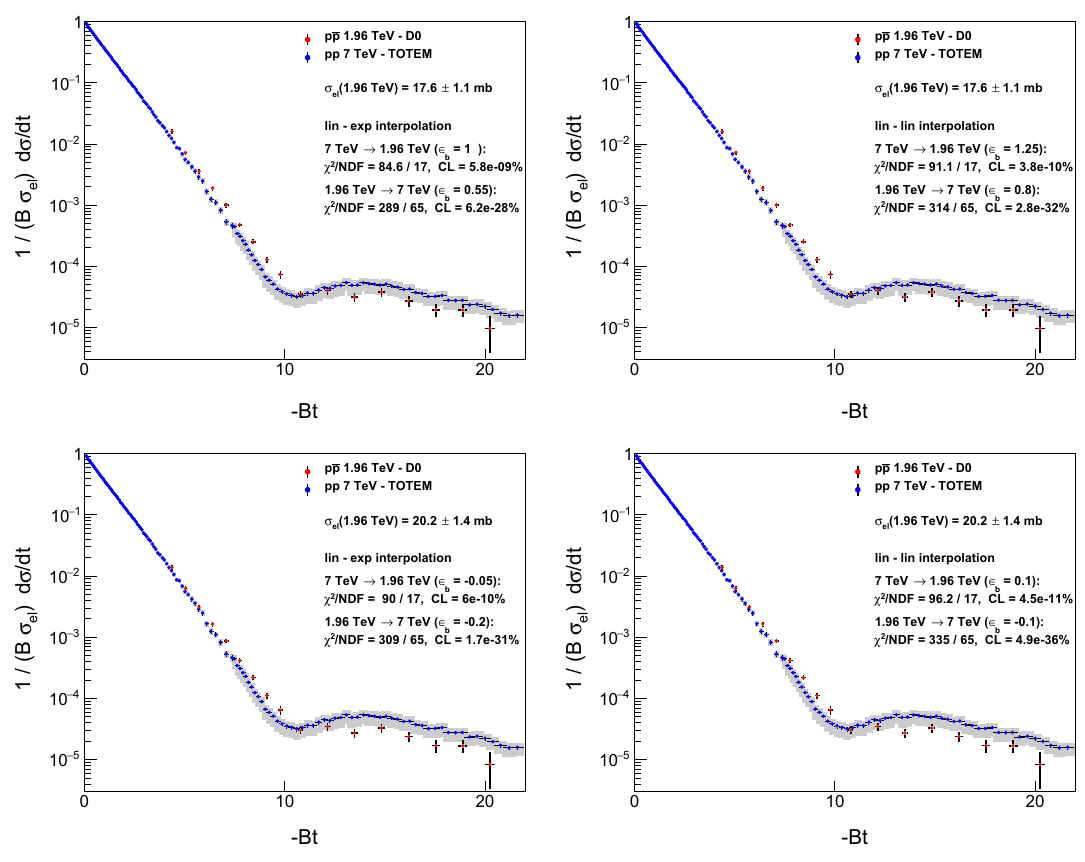
Fig. 10 Odderon signal in the comparison of the H ( x ) scaling func- a linear-exponential interpolation technique in ( x , H ( x )) . This corre- √ s = 7 TeV, measured by the TOTEM exper- tions of pp collisions at sponds to the smallest difference between the two data sets. Top-right √ s = 1 . 96 TeV iment at the LHC [28,74], and p ¯ p elastic collisions at panel: Same as the top-left panel but for linear-linear interpolations in measured by the D0 experiment at Tevatron [8]. The results of this the horizontal and vertical directions. For these interpolations, the near- preliminary Odderon observation are indicated on the plots, where the est data points are connected with lines that correspond to a straight CL is evaluated without the rounding of the χ 2 values to the printed line on a linear-linear plot. Bottom-left panel: Same as the top-left panel but now using 20 . 2 ± 1 . 4 mb for the elastic p ¯ p cross section level of precision. The rounded values of χ 2 and the corresponding √ s = 1 . 96 TeV. Bottom-right panel: Same as the bottom-left panel at CL values are summarized in Table 2. The final Odderon significance results are given in Appendix A. Top-left panel: This comparison uses but using a linear-linear interpolation √ s = 1 . 96 TeV, and 17 . 6 ± 1 . 1 mb for the elastic p ¯ p cross section at